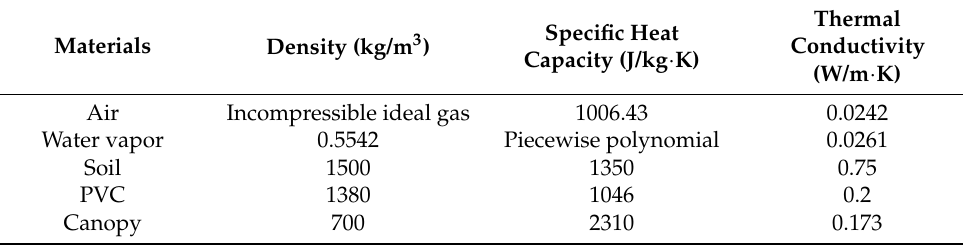
Table 1. Physical and thermal parameters of the different materials that constituted the greenhouse and the crop.